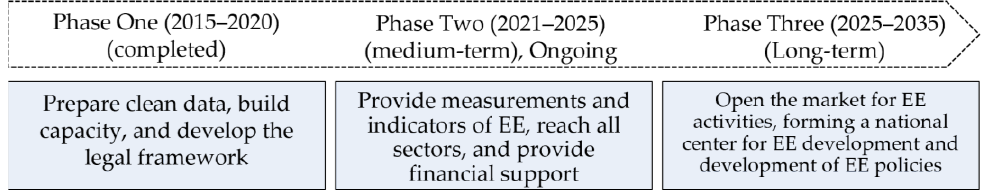
Figure 4. NEEAP’s implementation and time frame.